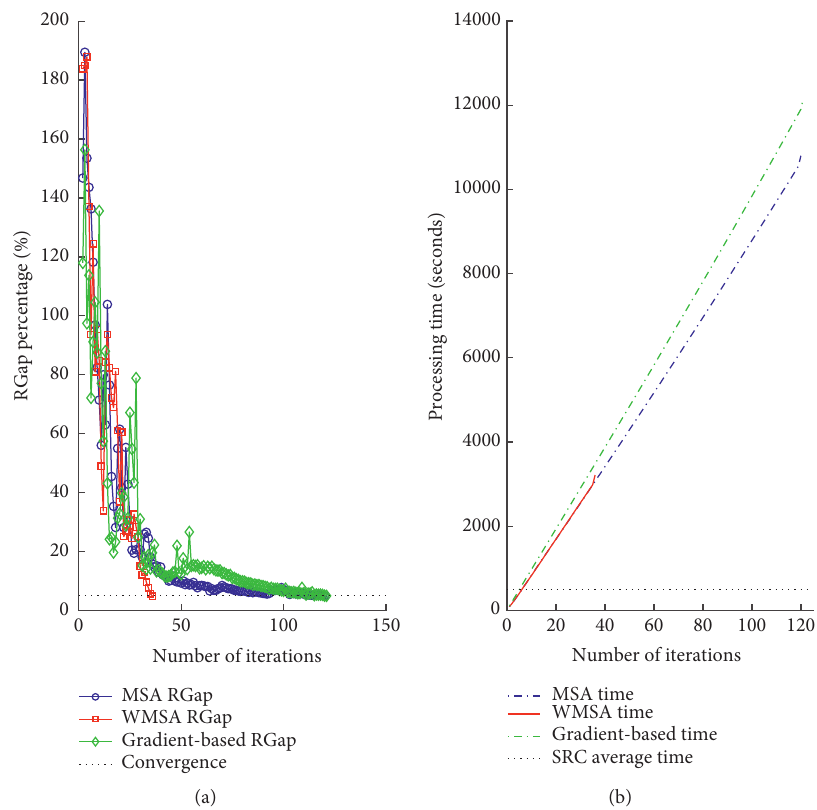
Figure 2: Computational time performance and the relative gap of DUE methods (MSA, WMSA, and gradient-based) with the number iterations represented on the x -axis of both plots, whereas the left plot displays maximum relative gap at each iteration and the right plot represents the progression of processing time in seconds with respect to the number of iterations.